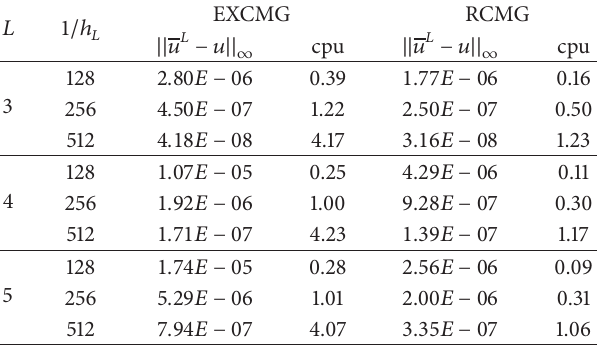
Table 2: Numerical results of EXCMG and RCMG for Example